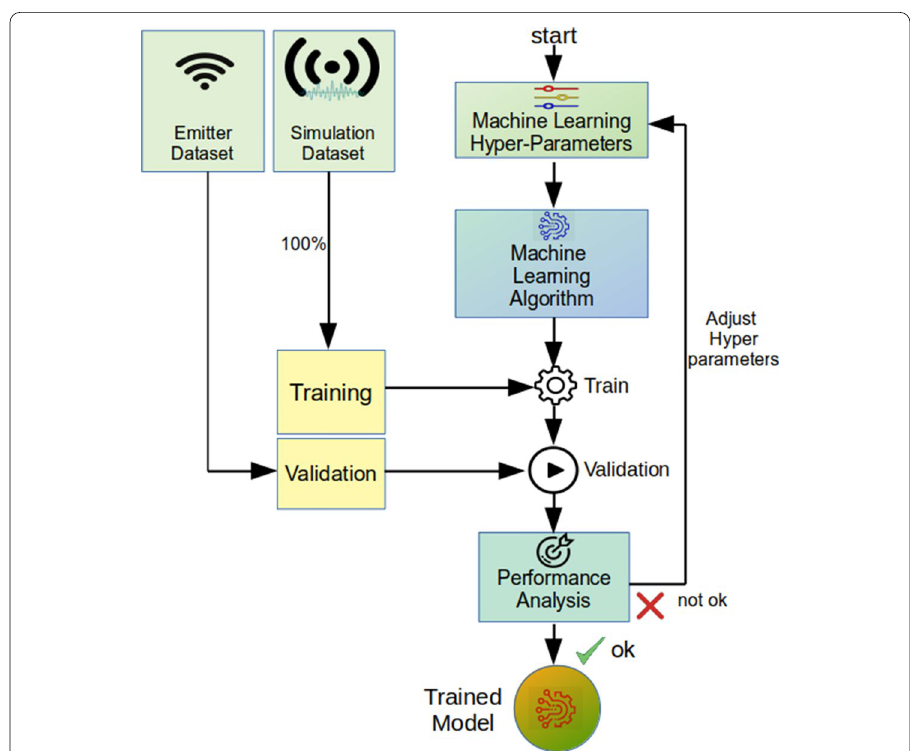
Fig. 8 Training process using simulation dataset and emitter dataset